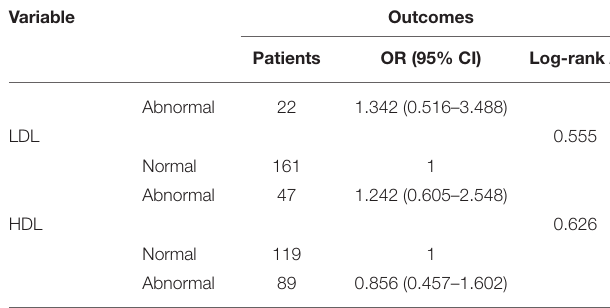
TABLE 4 | Binary logistic regression analysis predicting outcomes.